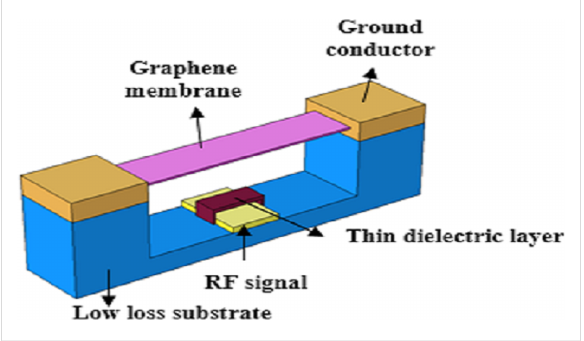
Figure 6: The structure of a GR-CPW phase shifter. Figure 6 was redrawn from [56].